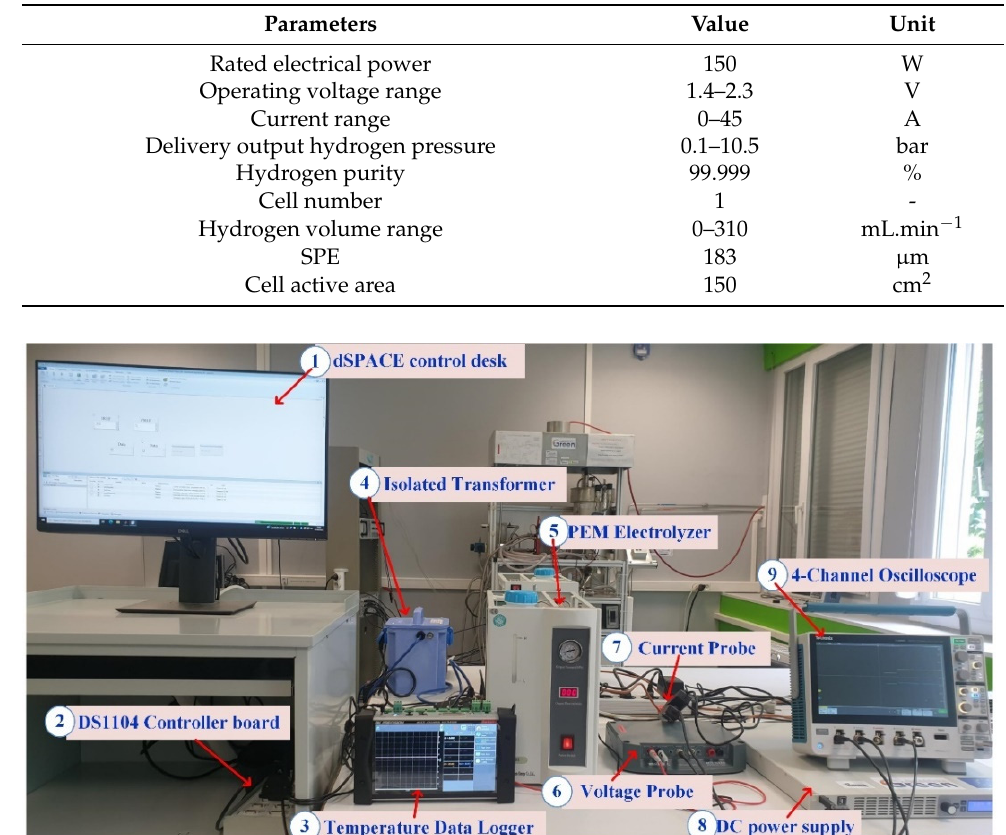
Table 1. Technical specifications of the PEM electrolyzer.